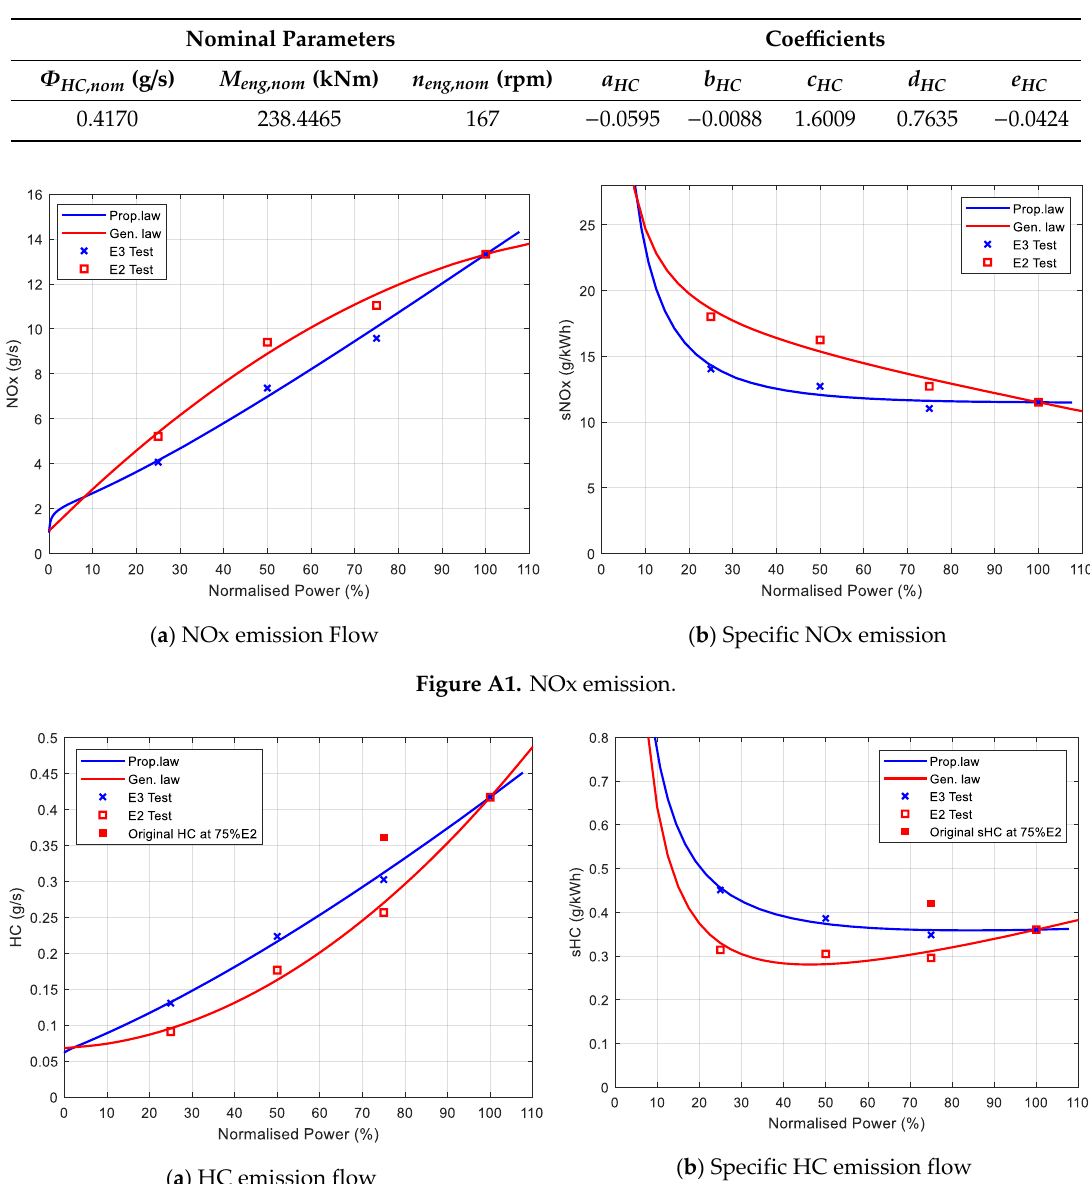
Table A3. Coefficients of engine torque model of auxiliary engine.